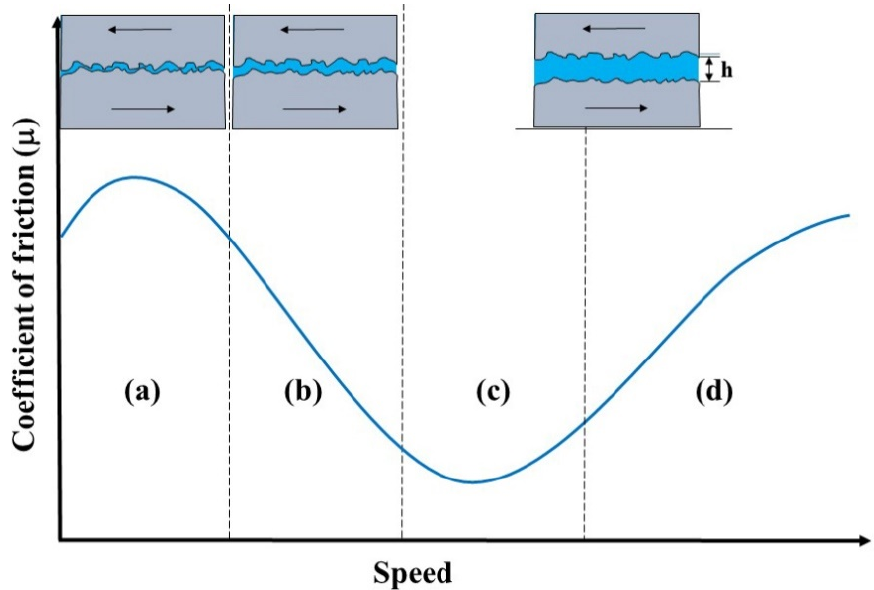
Figure 1. Stribeck curve: coefficient of friction as a function of speed ( a ) the boundary regime); ( b ) the mixed regime; ( c ) the elasto-hydrodynamic regime; ( d ) the hydrodynamic regime).